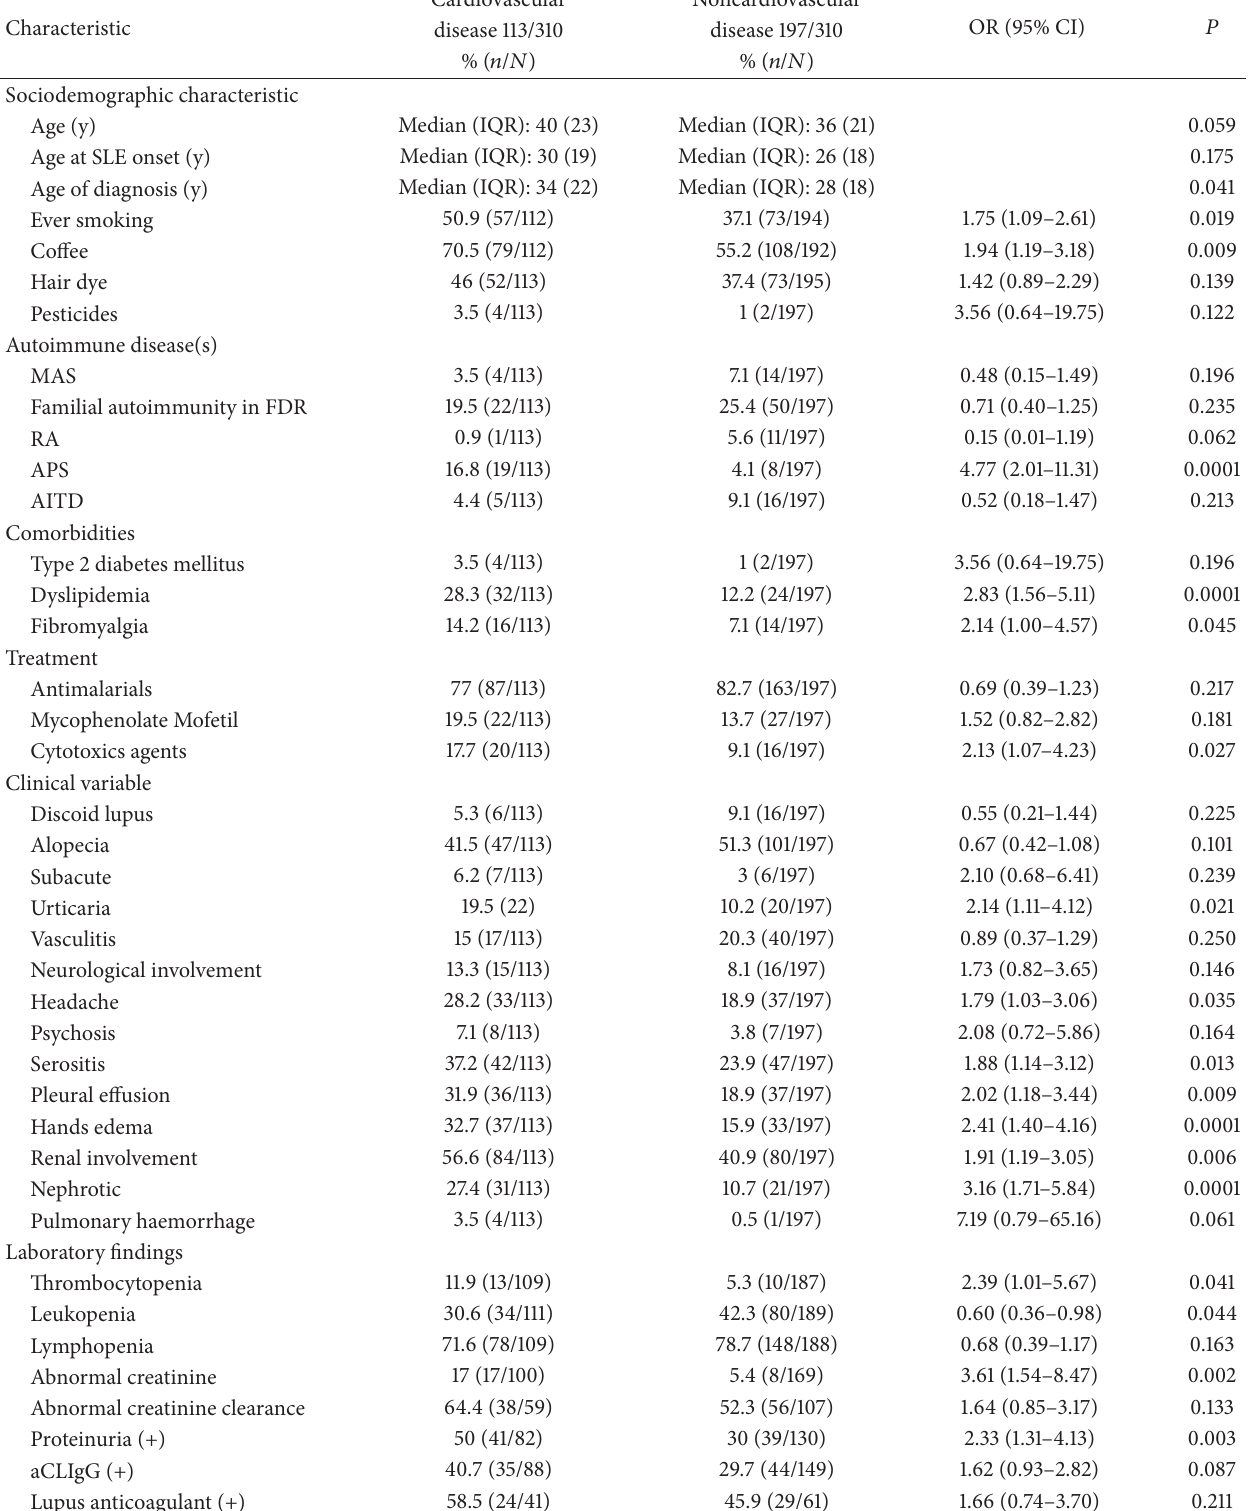
Table 3: Characteristics associated with CVD in 310 patients with